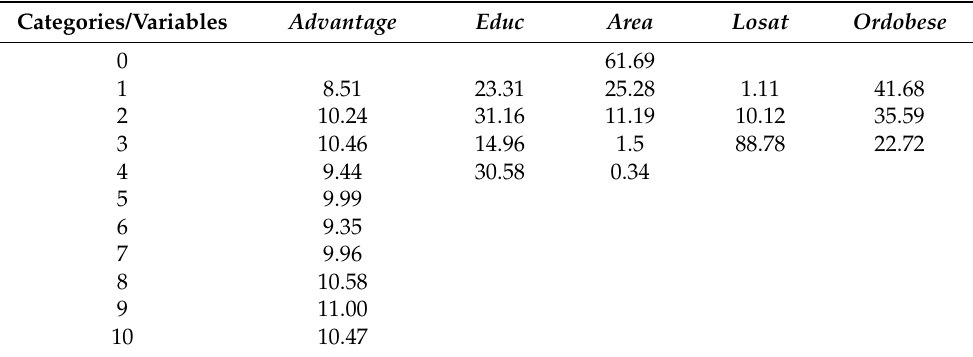
Table 2. The frequency distribution of categorical variables (percent).